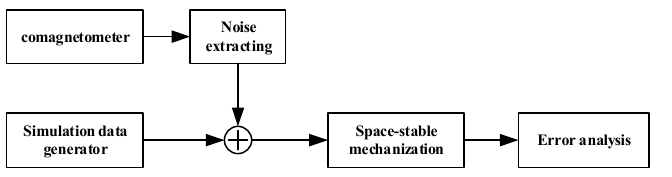
Figure 4. Numerical simulation based on semi-physical data.